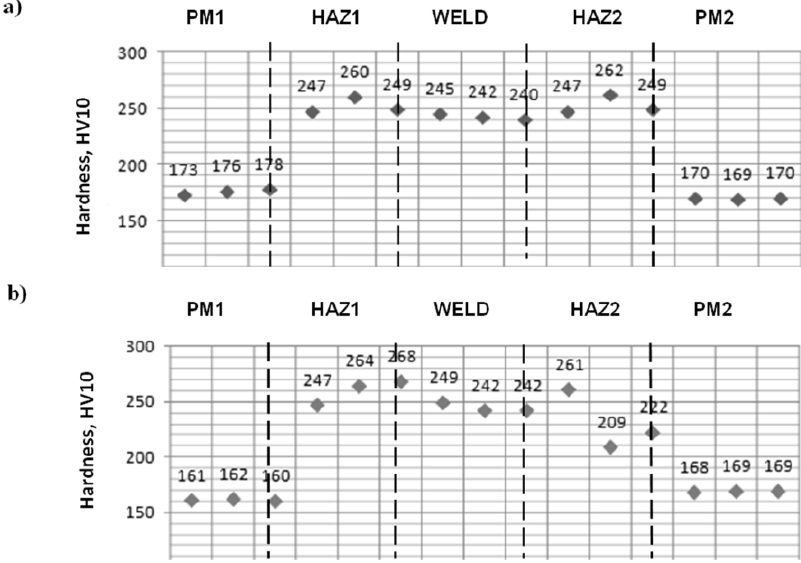
Figure 5. Distribution of the results of HV10 hardness measured on transverse microsections of the